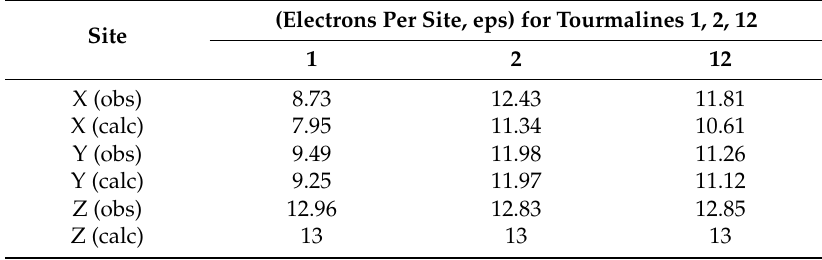
Table 6. Observed (Single Crystal XRD) and calculated (EMPA) site